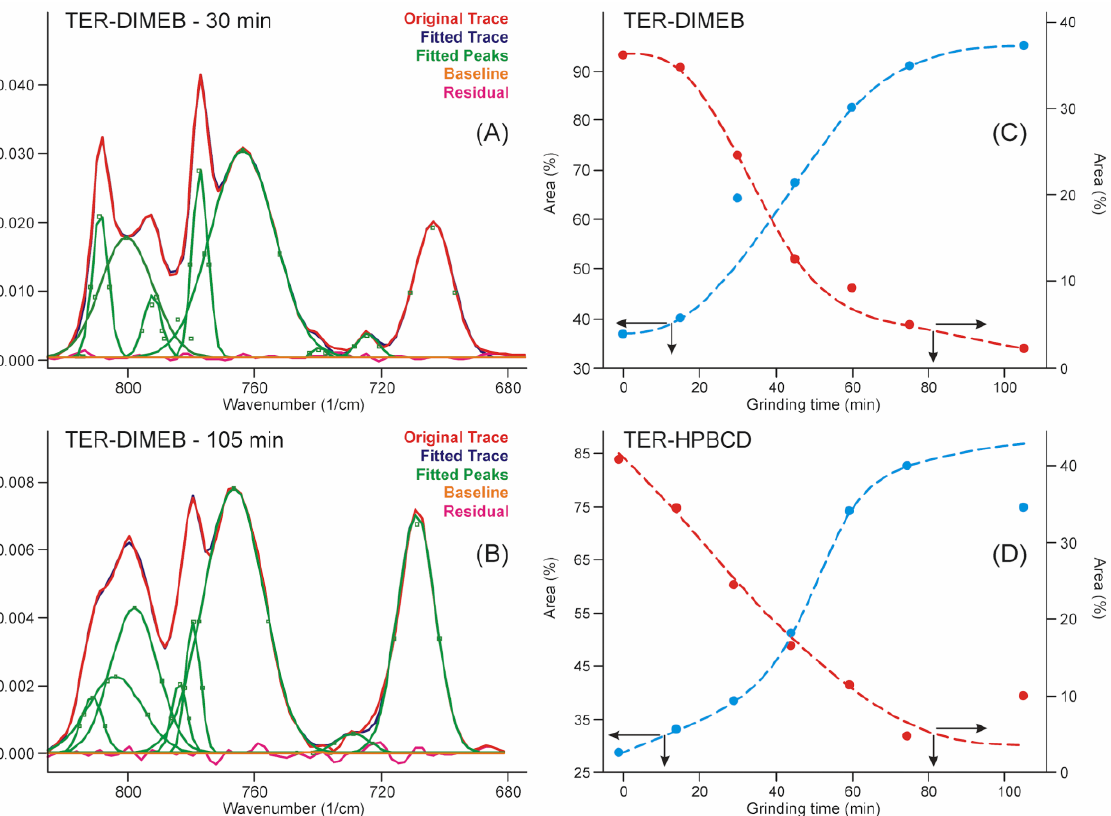
Figure 7. Peak fitting of FTIR spectra in the range of the out-of-plane deformation region resulted in a sigmoid type of curves with the grinding time, which confirmed the expected autocatalytic phase transformation type of kinetics of the product formation. ( A ) — fitted curves after 30 min grinding with residues of the starting materials in the TER-DIMEB mixture, ( B ) — fitted curves after 105 min grinding without residues of the starting materials in the TER-DIMEB mixture. Kinetic curves for the starting materials and the products constructed from the areas of the fitted peaks ( C ) — in the case of TER-DIMEB, and ( D ) — in the case of TER-HPBCD mixture. The kinetic curves were calculated from the contribution of the areas of the peaks of increasing and those of decreasing intensities to the sum of the peak areas.